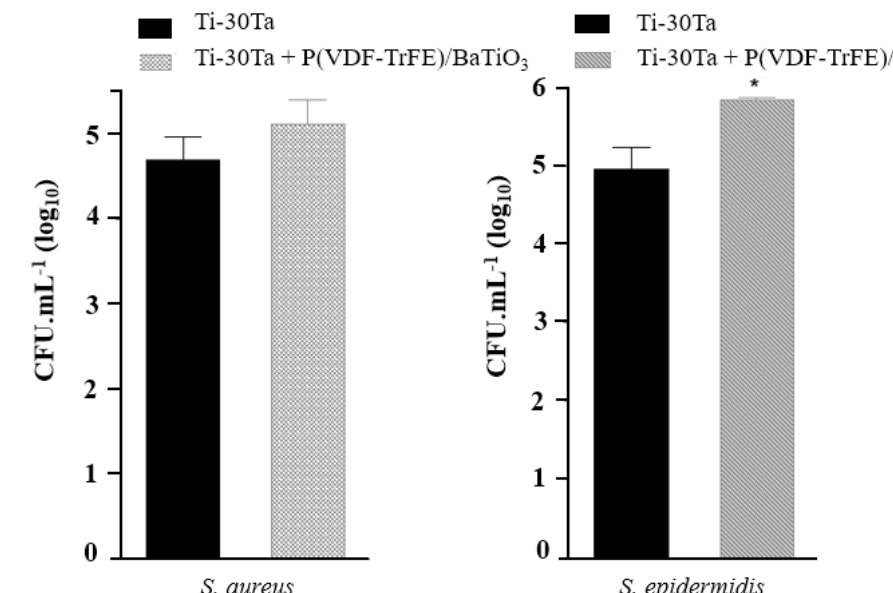
Figure 13. Comparative bar chart of colony-forming units (CFU) for S. aureus and S. epidermidis obtained using Student’s t -test. * indicates that the difference between the samples are statistically significant ( p < 0.05) when compared to the non-coated and coated samples for S. epidermidis.